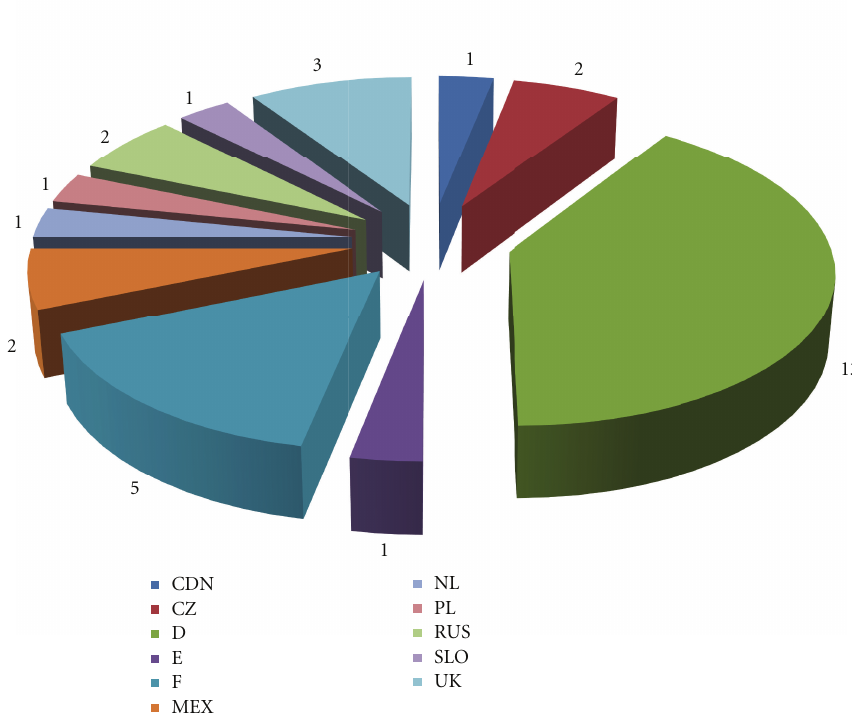
Figure 3: Nationalities of the participants in the KIT 2012